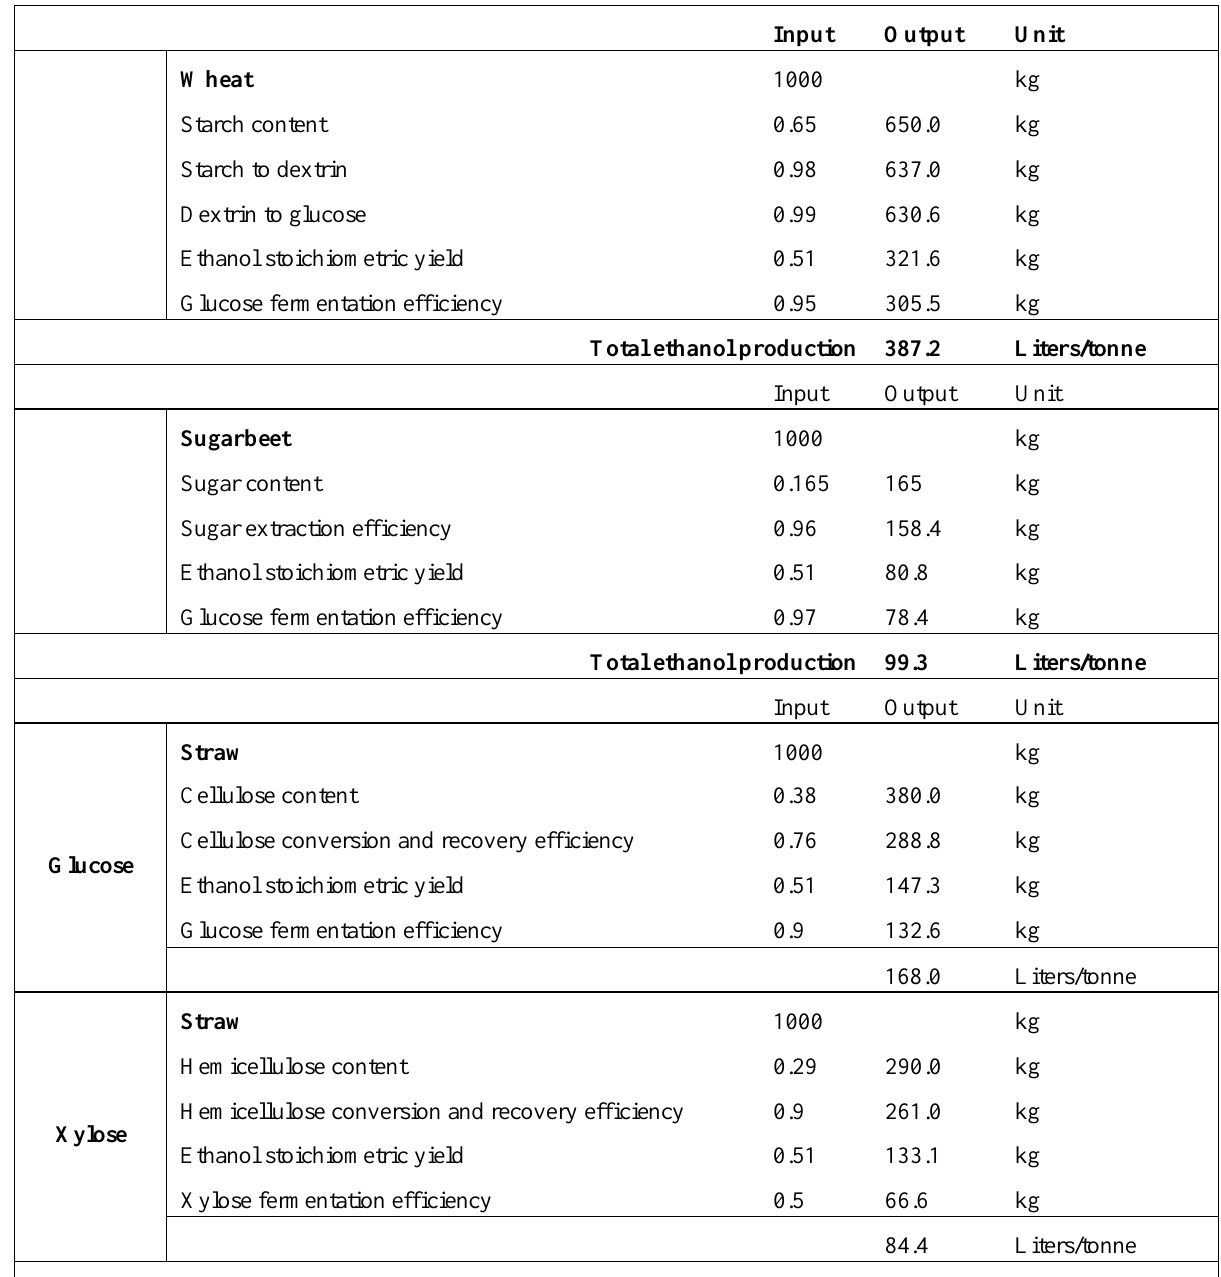
Table 2. Estimated ethanol yield from the modeled feedstock straw, sugarbeet and